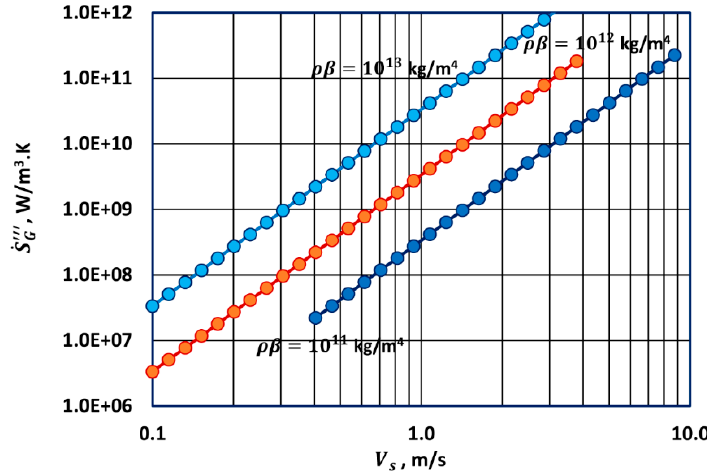
Figure 19. E ff ect of ρβ on the rate of entropy generation per unit volume of consolidated porous Figure 19. Effect of (cid:2025)(cid:2010) on the rate of entropy generation per unit volume of consolidated porous medium in turbulent regime ( T = 298.15 K, µ = 10 mPa · s, k = 10 − 12 m 2 ). The data points are generated medium in turbulent regime ( (cid:1846) = 298.15 K, (cid:2020) = 10 mPa·s, (cid:1863) = 10 − 12 m 2 ). The data points are generated using Equation (67). using Equation (67).